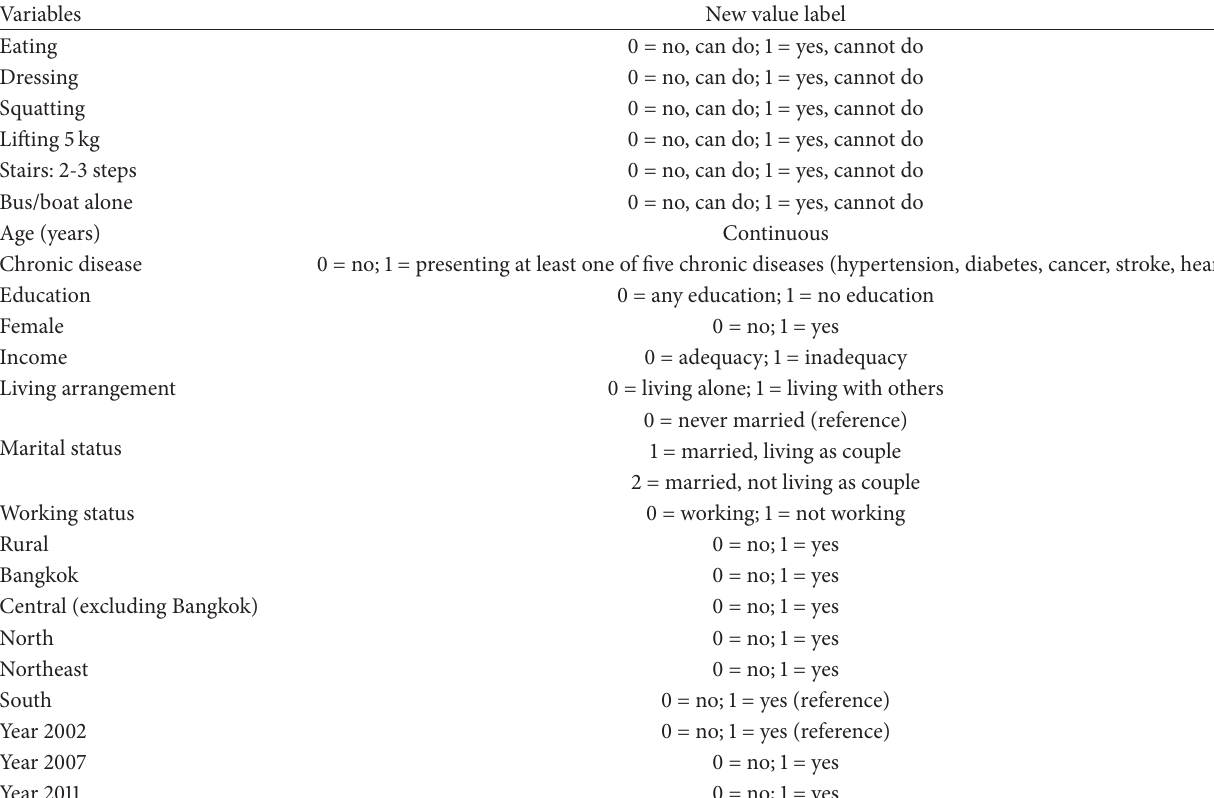
Table 2: New study